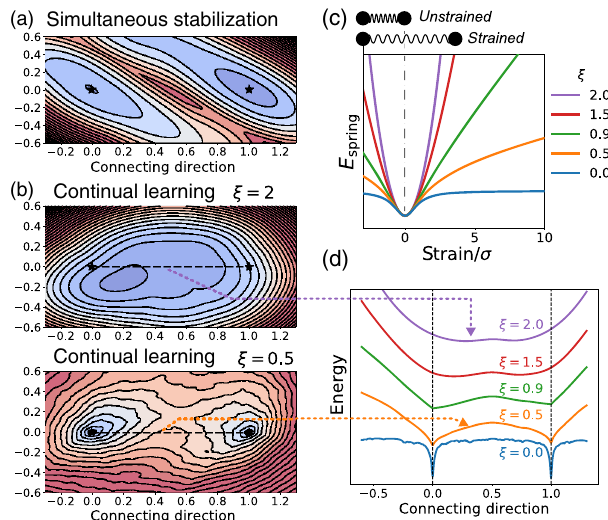
FIG. 2. Nonlinear interactions are essential for learning multi- ple states in sequence. (a) Energy landscape of a simultaneously stabilized network with linear ( ξ ¼ 2 ) springs, successfully stabilizing 2 desired states (black stars). (b) In the continually learned network, linear ( ξ ¼ 2 ) springs learned for each desired state destabilize the other state, but nonlinear ( ξ ¼ 0 . 5 , σ ¼ 5 × 10 − 3 L ) learned springs stabilize both desired states. (c),(d) Repeating learning for nonlinear springs with E ∼ s ξ , we find that learned states overwrite each other for ξ > 1 but are protected from each other with sufficiently nonlinear ξ ≤ 1 springs.